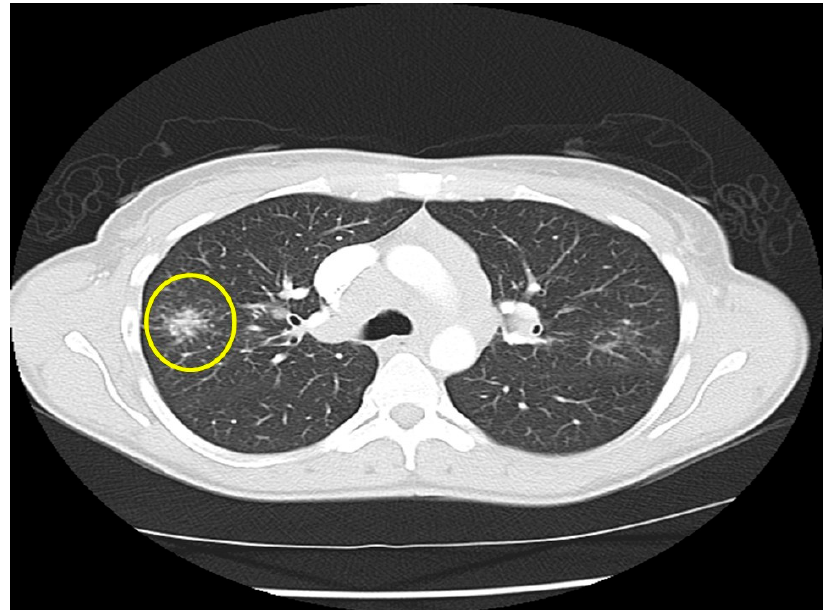
Figure 5. Chest CT image of a “galaxy sign” in a patient with pulmonary sarcoidosis. Micronodules coalescence into a central mass-like lesion (within circle).